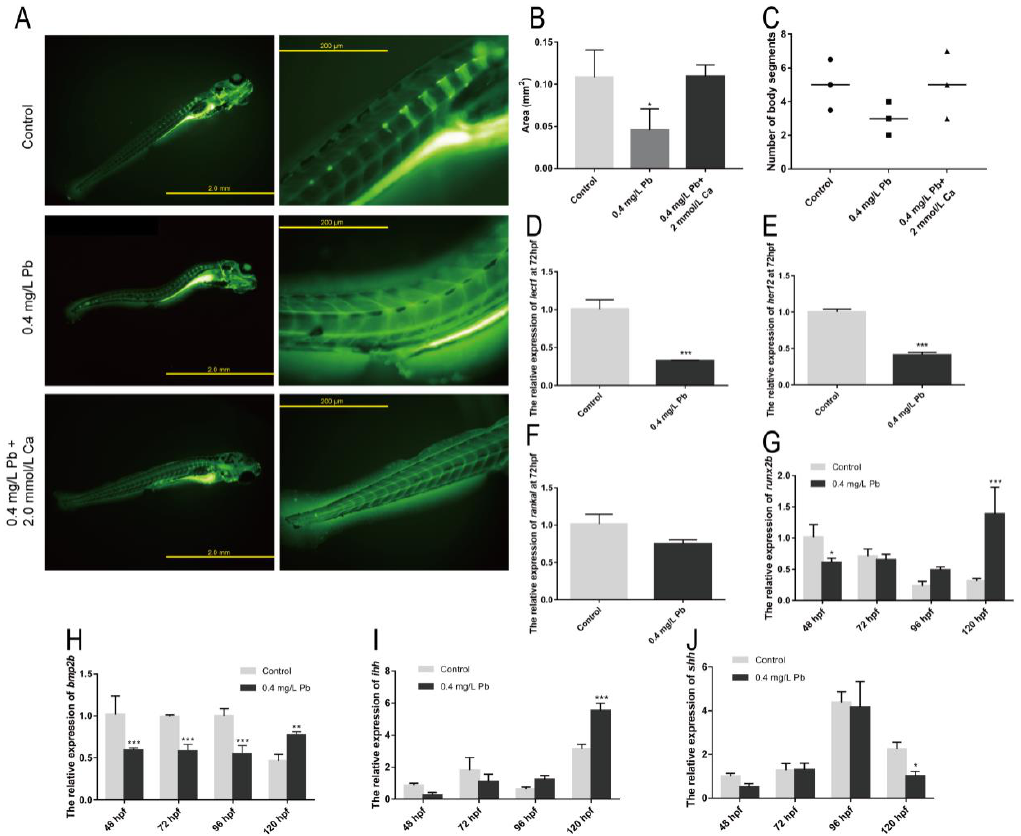
Figure 3. Skeletal and somites development. ( A ) Calcein staining; ( B ) Area of ossification in juvenile zebrafish; ( C ) Body segment statistics. The expression of the somites development-related genes is shown for ( D ) lect1, ( E ) her12 , ( F ) rankal ( G ) runx2b , ( H ) bmp2b . The expression of Hedgehog signaling pathway gene of zebrafish embryos is shown for ( I ) ihh and ( J ) shh , with ef1 α as reference. (* p < 0.05, ** p < 0.01, *** p < 0.001, n =